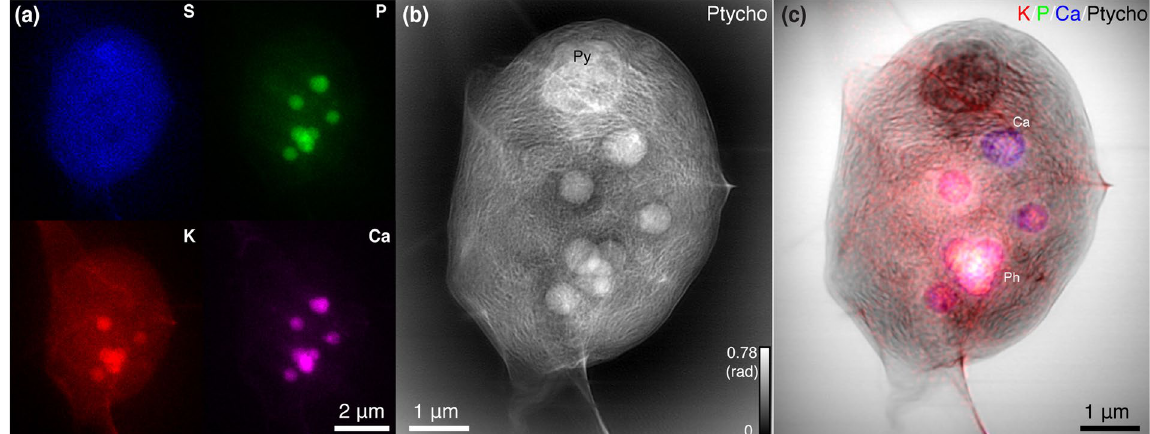
Figure 2. Fluorescence and ptychographic x-ray images of a second unsectioned frozen-hydrated Chlamydomonas alga. X-ray fluorescence images ( a ) show the distribution of S, P, K, and Ca within the plunge- frozen cell. The 5.2 keV x-ray ptychographic phase contrast image ( b ) shows unlabeled subcellular structures, including a big pyrenoid (Py) on the top. Because the fluorescence and ptychographic image data are recorded simultaneously, the various images are in perfect registry allowing for ( c ) which is a color composite image overlay of K, P, and Ca on top of the ptychographic image. With this method, the electron-dense spherical structures in ( b ) can be identified as polyphosphate bodies (Ph) that contain polyphosphate complexed with calcium 58 . Again, the granule (labeled Ca) seems to be different from other polyphosphate bodies as it contains less potassium, which suggests that this granule might undergo degeneration or